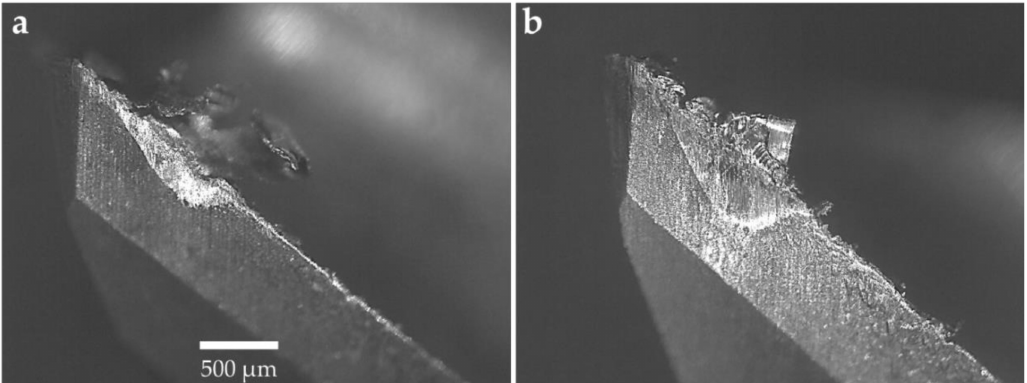
Figure 5. Micrographs of the tool with a 10 ◦ rake angle: ( a ) 10 ◦ primary clearance angle and ( b ) 8 ◦ primary clearance angle.